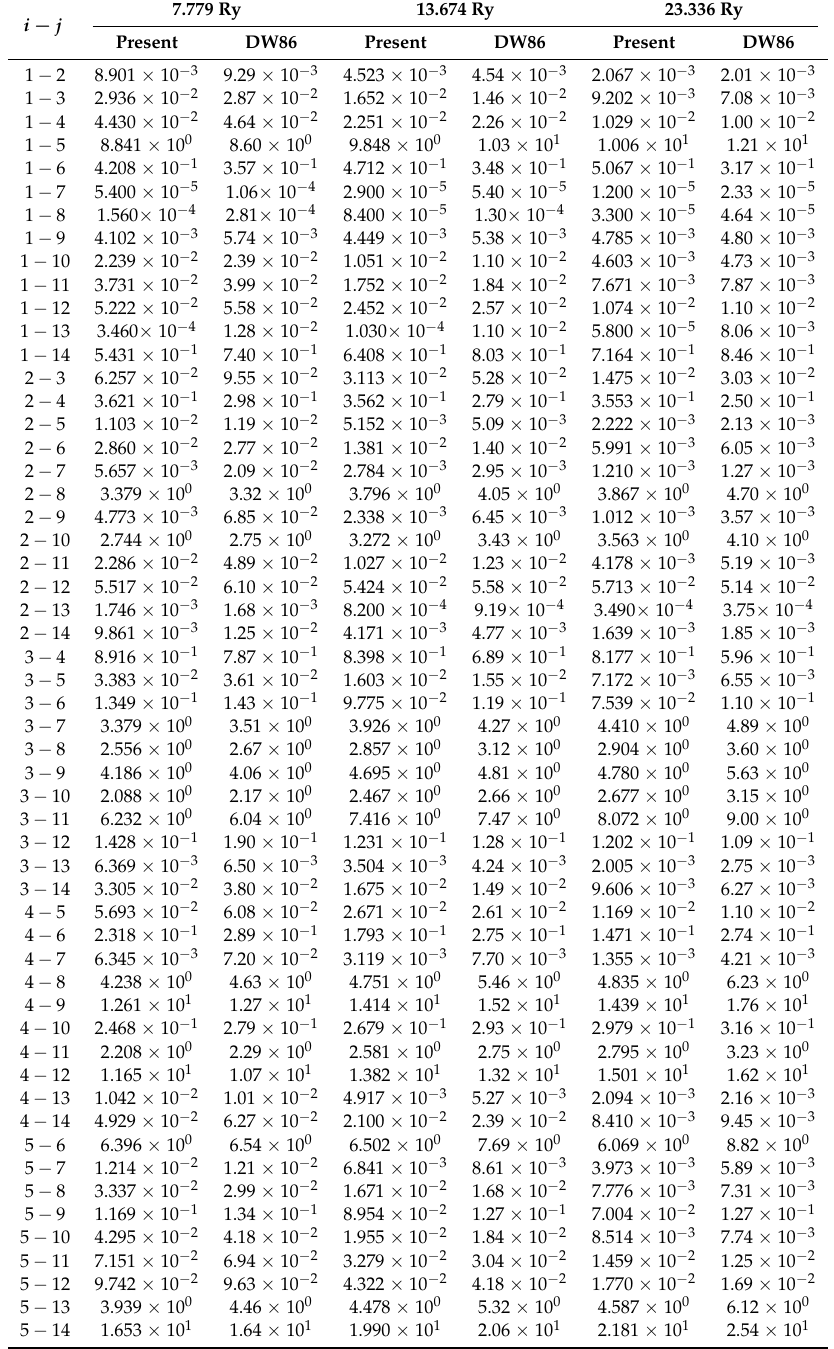
Table 3. Our collision strengths Ω ij (Present) and those from [26] (DW86) where 1 ≤ i ≤ 5 and i + 1 ≤ j ≤ 14. i and j label the levels as in Table